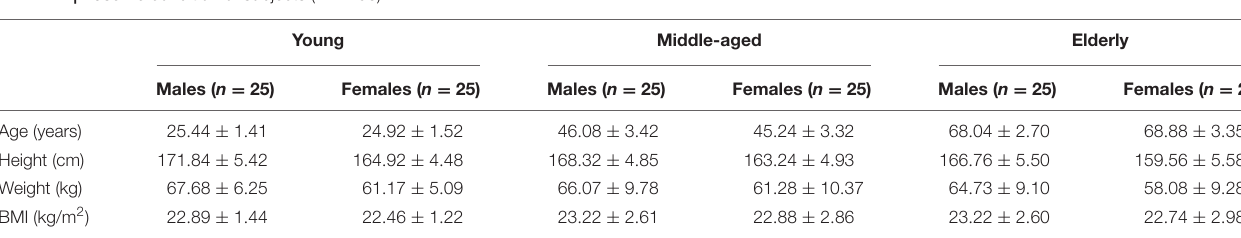
TABLE 1 | Baseline condition of subjects ( n = 150).